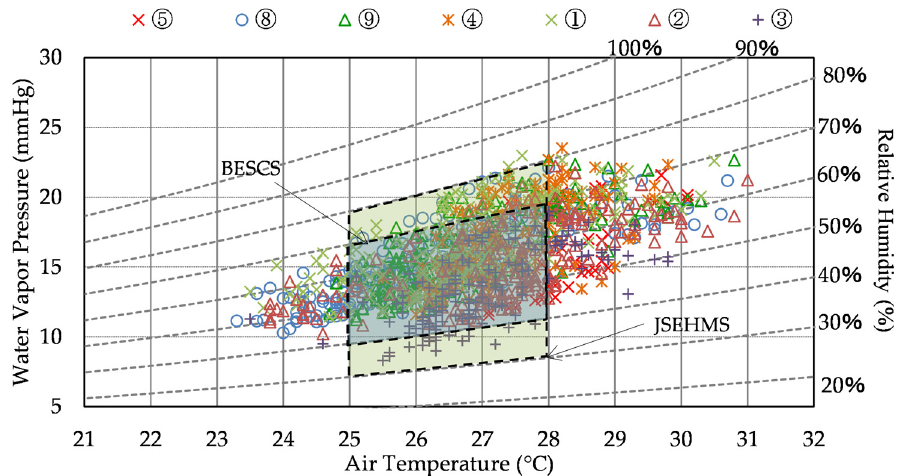
Figure 14. Summer psychometric chart for class C.